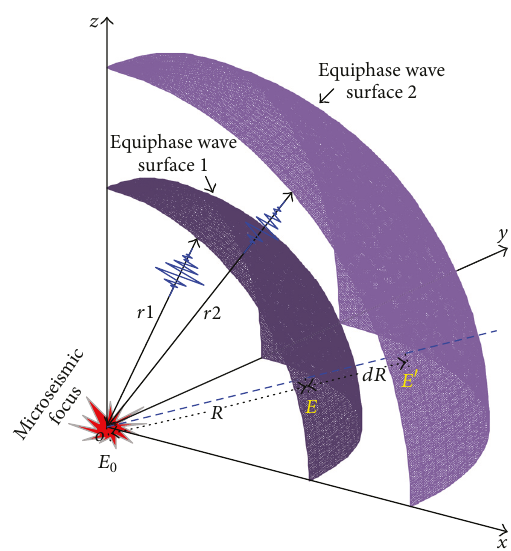
Figure 3: Theoretical analysis model of microseismic focus energy attenuation